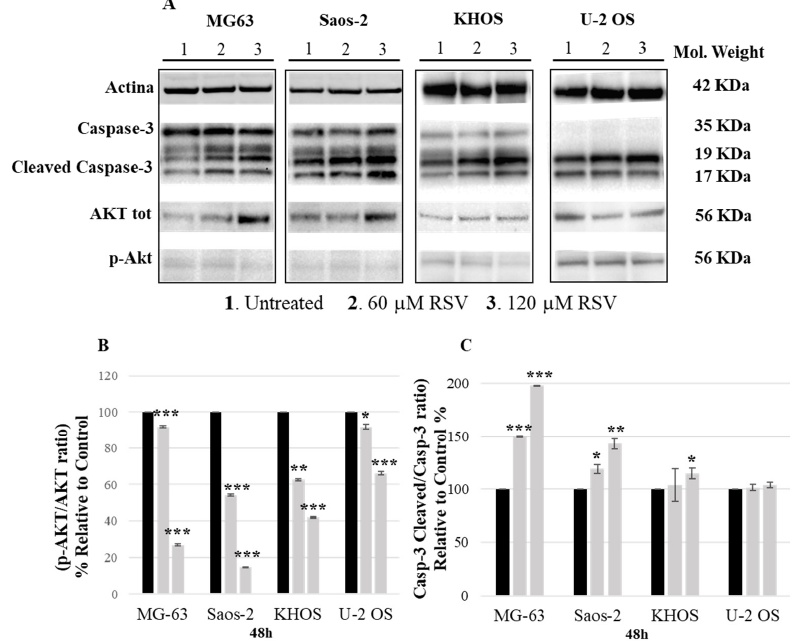
Figure 3. RSV regulates caspese-3 and AKT in OS cells. ( A )—Representative Western blotting analysis of OS cell expression proteins treated with 60 or 120 µ M RSV for 48 h. Actin was used as a load control. ( B , C )—Densitometric quantification of the percentage expression of the ratio p-Akt/Akt ( B ) and cleaved caspase-3/caspase-3 ( C ) of the untreated cells compared to the cells treated with RSV (mean ± SD, n = 4). A One-way ANOVA test was used to evaluate the effect of the RSV treatment factor (60 and 120 µ M) on the regulation of caspase-3 (MG-63—F = 534, p < 0.0005; Saos-2—F = 123, p < 0.0005; KHOS—F = 2.5, p < 0.0005; U-2 OS—F = 2.2, p < 0.0005) and AKT (MG-63—F = 3011, p < 0.0005; Saos-2—F = 695, p < 0.0005; KHOS—F = 135, p < 0.0005; U-2 OS—F = 110, p < 0.0005). Dunnett’s test: *, p < 0.05; **, p < 0.005; ***, p < 0.0005 versus untreated cell